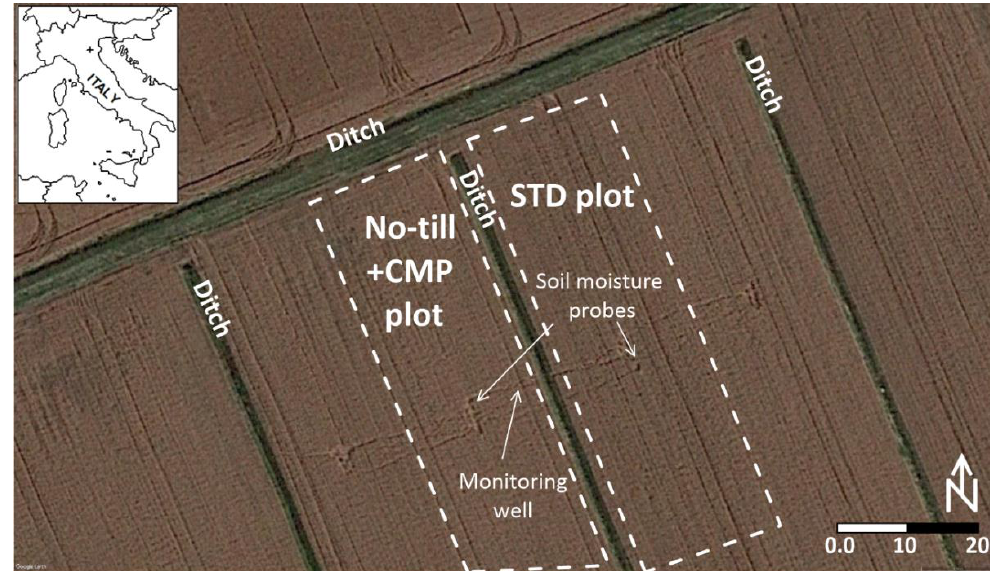
STD Plot STD Plot No-till + CMP Plot (kg-N / ha) (kg-N / ha)